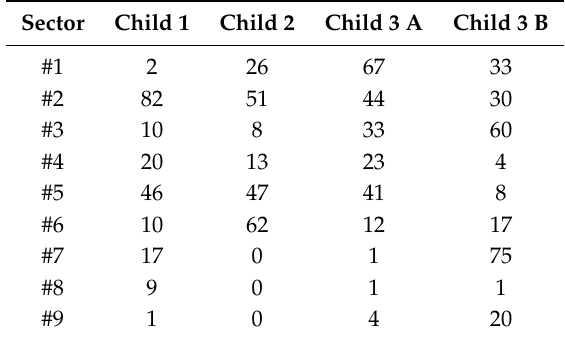
Table 4. Account of visual hits for each experimental session.